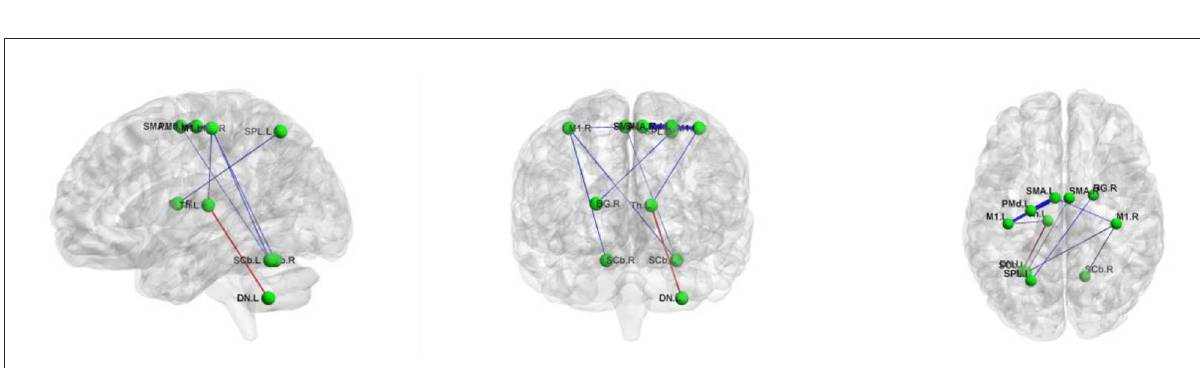
FIGURE4 The connected component with altered functional connectivity strength in Wilson’s disease patients. Edge colors represent increased (red) and decreased (blue) functional connectivity strength in the patients. Edge sizes represent T values. BG, basal ganglia; DN, dentate nucleus; L, left; M1, primary motor cortex; PMd, dorsolateral premotor cortex; R, right; SCb, superior cerebellum; SMA, supplementary motor area; SPL, superior parietal lobule; Th,